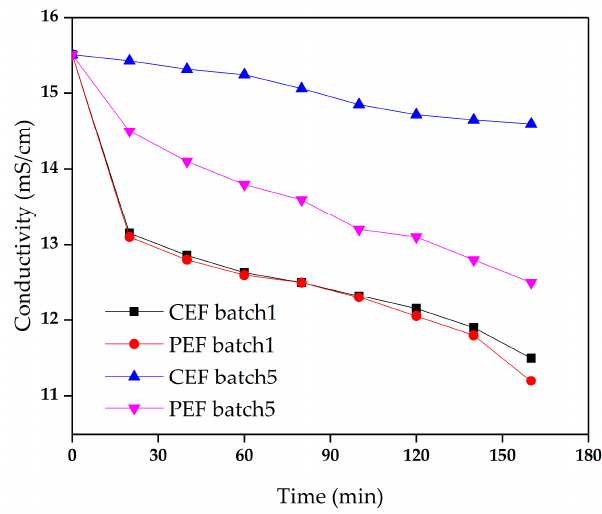
Figure 6. The conductivity of the dilute in the demineralization of sodium gluconate mother liquor in batch 1 and batch 5. The conventional direct-current power and the pulse direct-current power operated at constant voltage of 9 V.